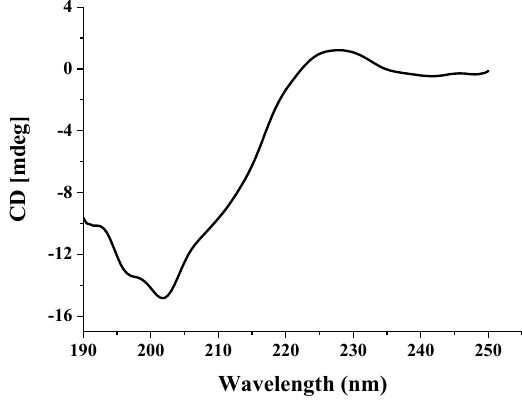
Figure 3. Circular dichroism spectrum of PHTI in distilled water.